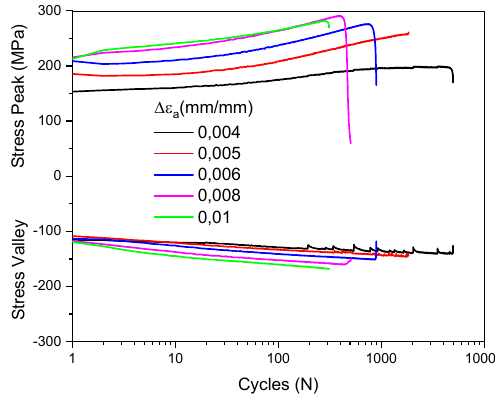
Figure 6. The profile of hardness values of extruded Mg AZ31B at different